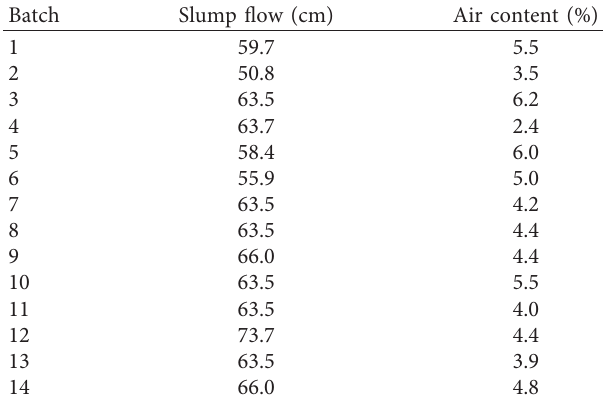
Table 3: Slump flow and air content test